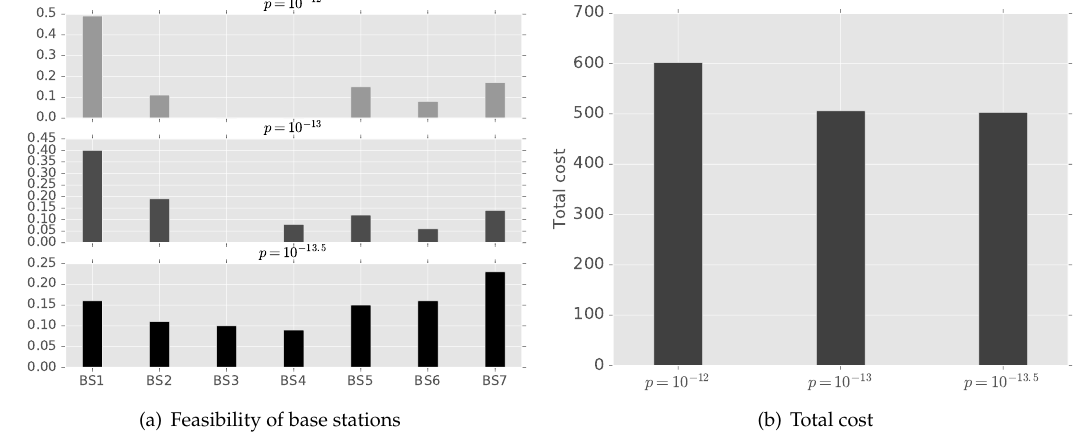
Figure 4. Average feasibility of base stations for cluster heads in Cell 1 with different power prices.